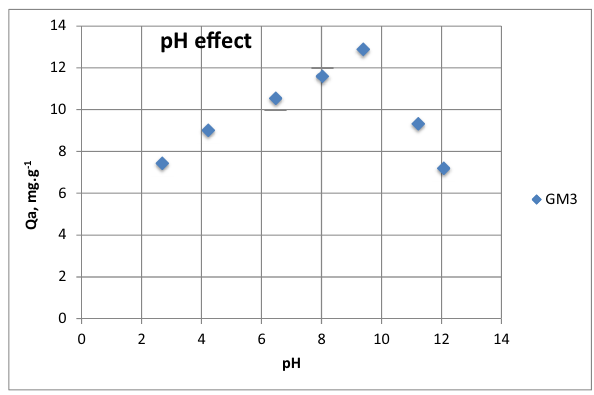
Figure 9: pH e ff ect on paracetamol adsorption onto